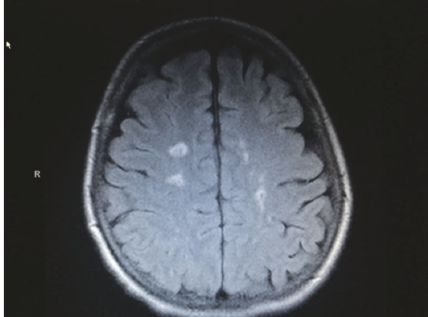
Figure3:Six-weekfollow-upMRIbrain(FLAIR)showingimprove- ment in bilateral hyperintense